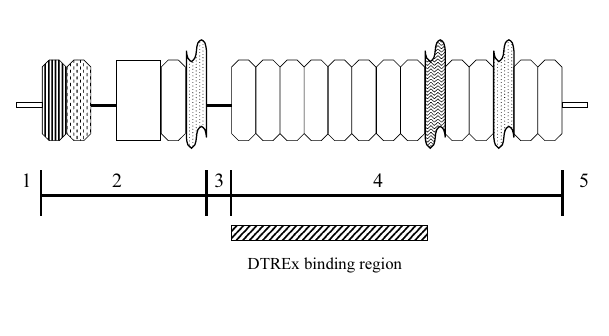
Figure 1 Diagrammatic representation of the human LTBP-3 protein. Note that for the amino acid sequence derived for the mon- key LTBP-3 (Mk LTBP-3), the monkey, mouse and human LTBP-3 proteins have the same structural features. Symbols represent structural features of the protein: cysteine-rich regions, patterned octagons; proline/glycine rich region, solid line; fibrillin motif, open rectangle; calcium-binding type II EGF-like modules, open octagons; cysteine-rich TGF-bp repeats, dotted punched tape symbol; TGF-bp-like repeat, wavy lined punched tape symbol. The numbers 1-5 represent different domains of the protein. The construct insert of pGAD424/LTBP-3 EGF #1-8, containing the region of Mk LTBP-3 that interacts with the extracellular domain of proHB-EGF (DTREx), is shown as a forward slashed